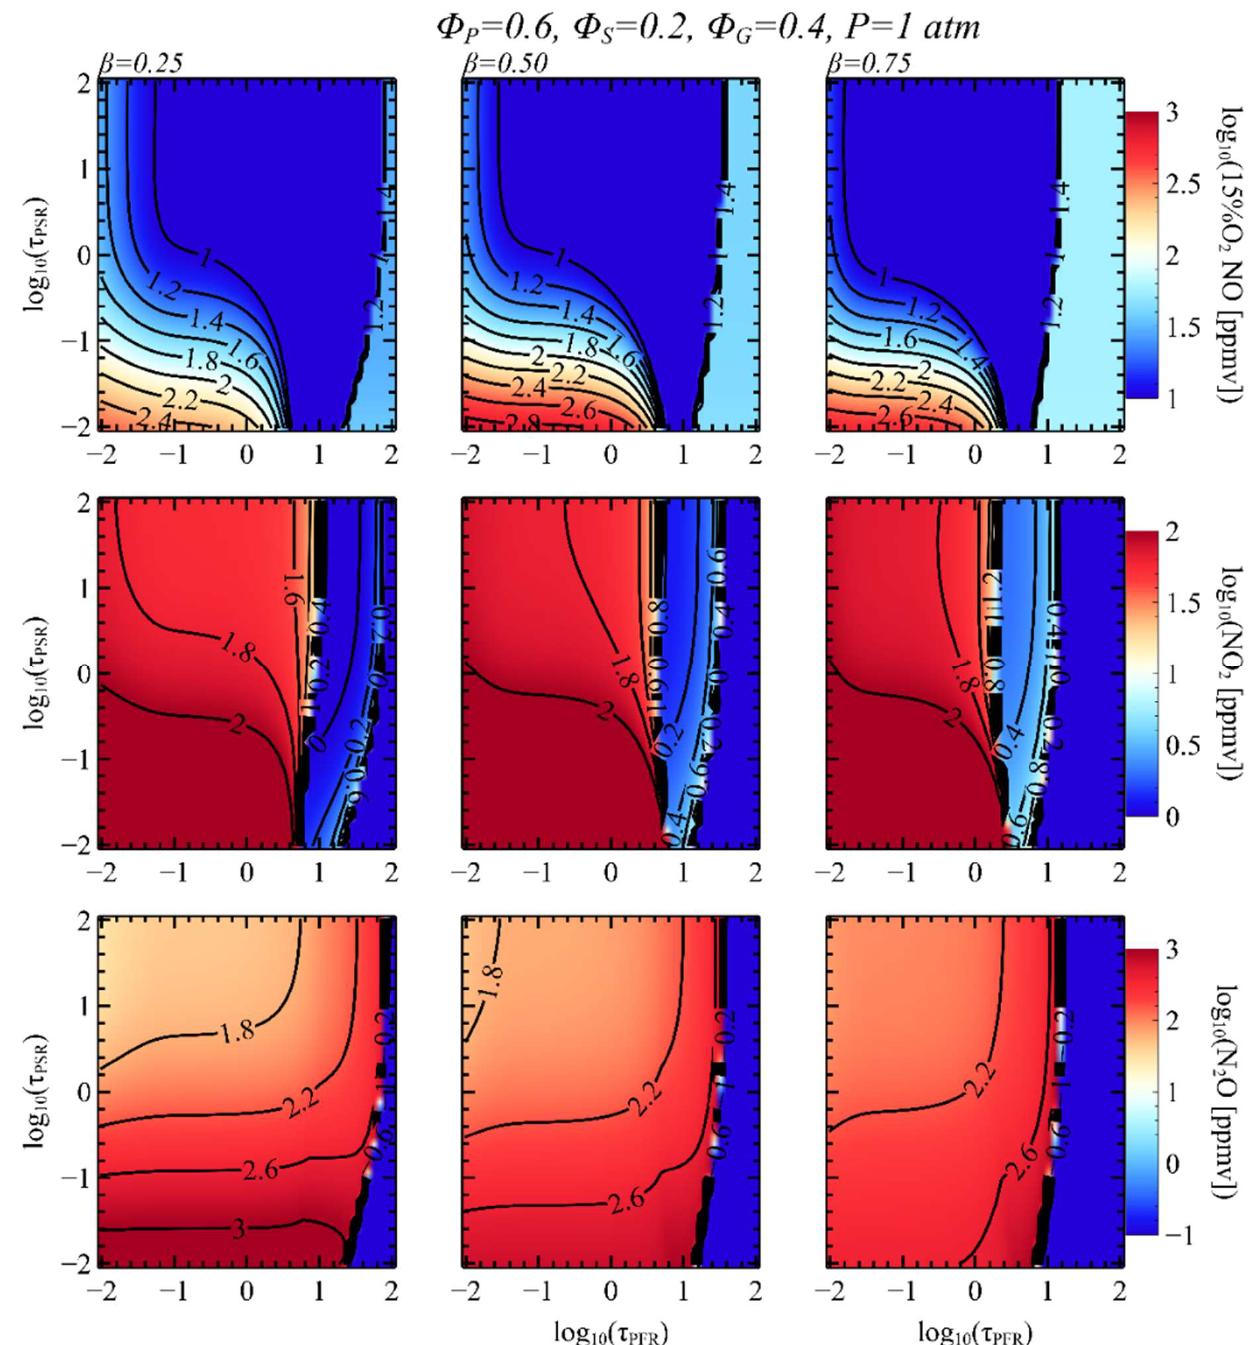
Figure 9. Contour maps of NO x emission in FS CRN. Each column represents computational results with different 𝛽 .